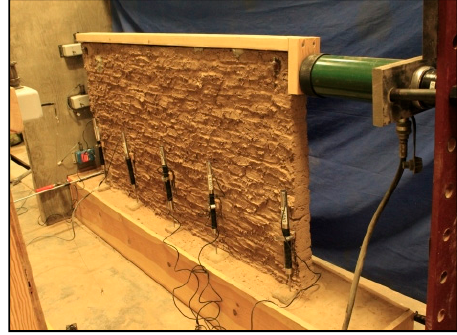
Figure 3. Wall model (Wall 1) with instrumentation and loading components.